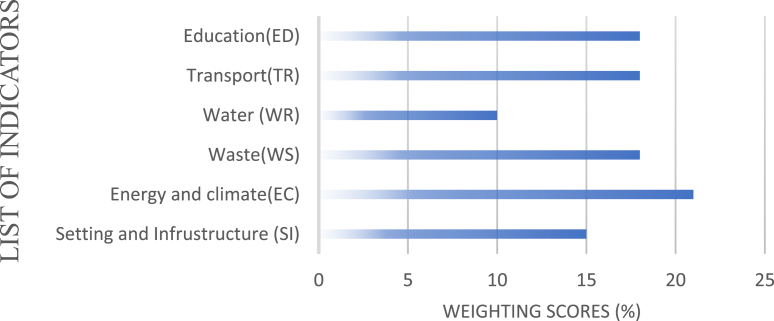
The 2019 UI GreenMetric Ranking and their weighting (UI GreenMetric, [36]).